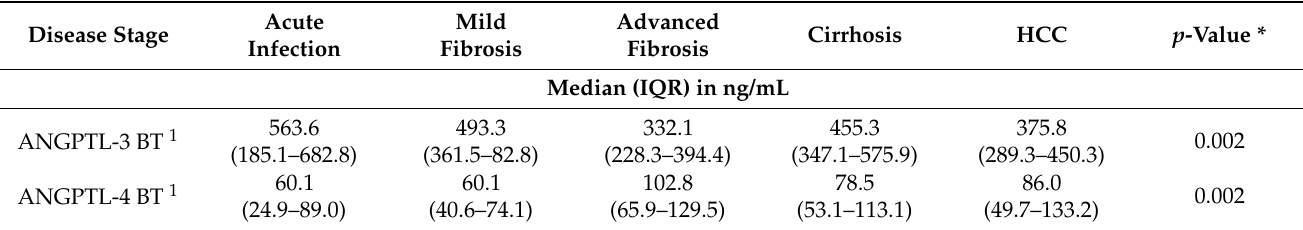
Table 3. ANGPTL-3 and ANGPTL-4 serum levels during the course of natural HCV infection. Disease